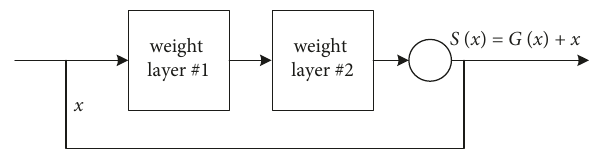
Figure 4: Residual network